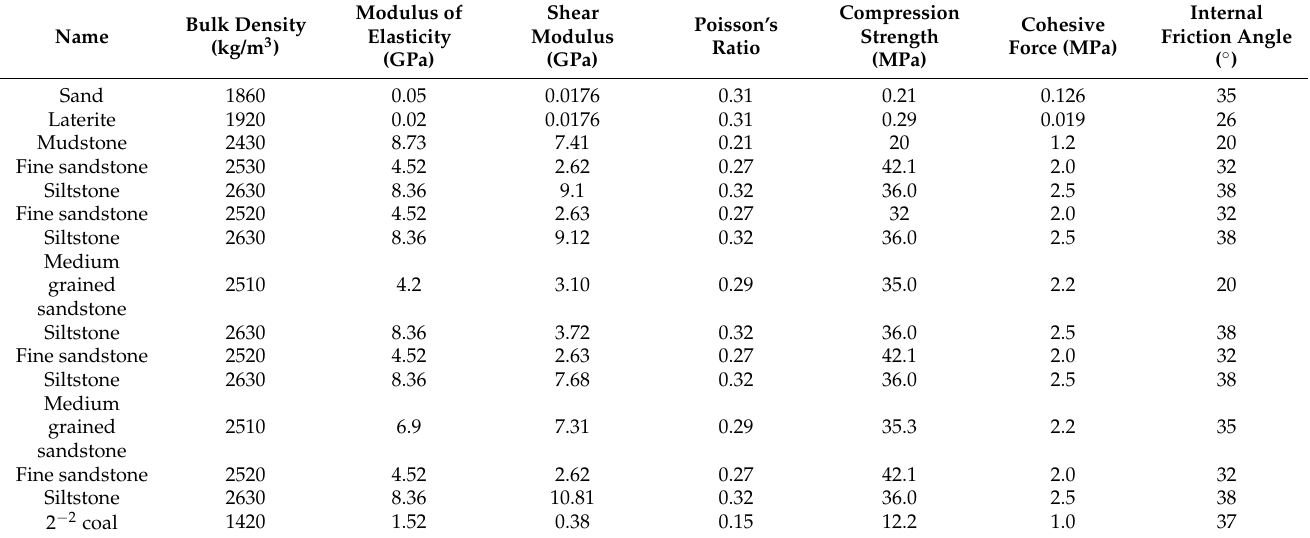
Table 1. The physical and mechanical parameters of coal seam and overlying